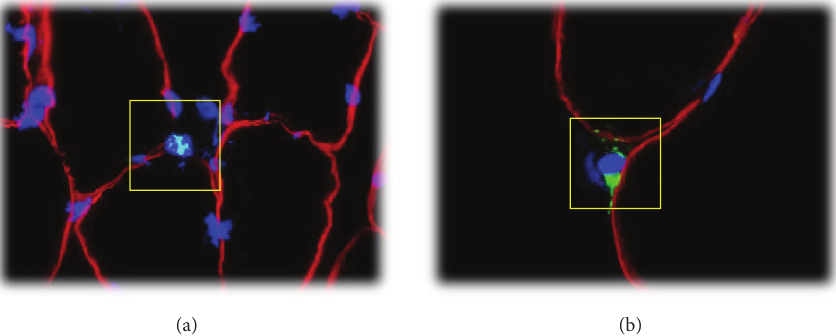
Figure 6: (a) CD66b positive cell (neutrophil granulocyte) inside the yellow square. Red stain: laminin, green stain: CD66b, and blue stain: DAPI (nuclei). (b) CD68 positive cell (macrophage) inside the yellow square. Red stain: laminin, green stain: CD68, and blue stain: DAPI (nuclei).